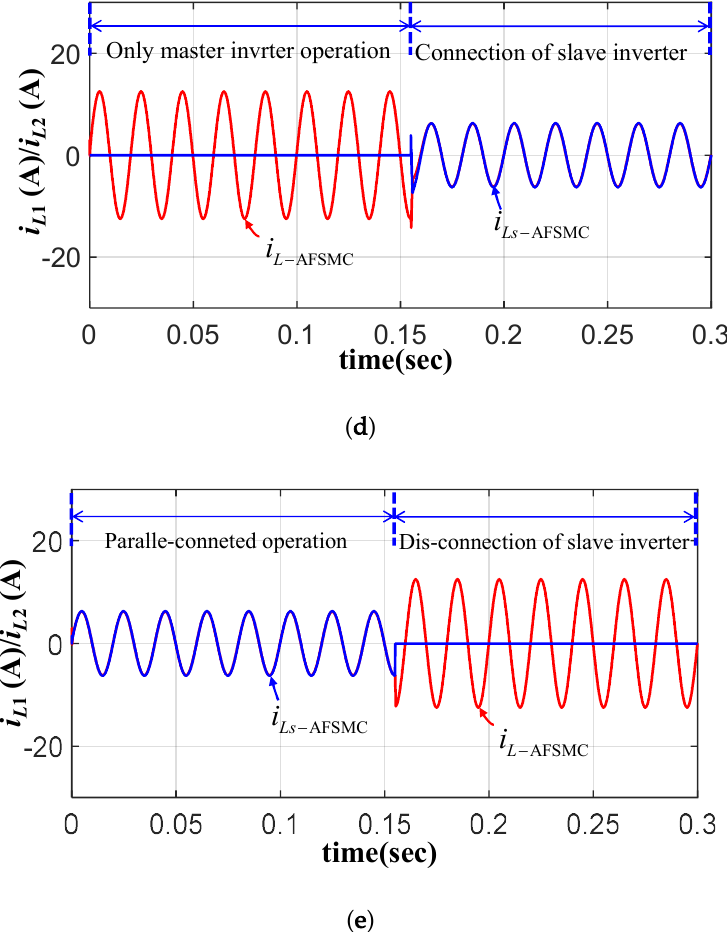
Figure 8. Simulated results of islanded inverter under connection and disconnection of slave inverter: ( a ) output voltage ( v o ); ( b ) voltage tracking error under connection; ( c ) voltage tracking error under disconnection; ( d ) Inductor currents ( i L and i Ls ) under connection; ( e ) Inductor currents ( i L and i Ls ) under disconnection.